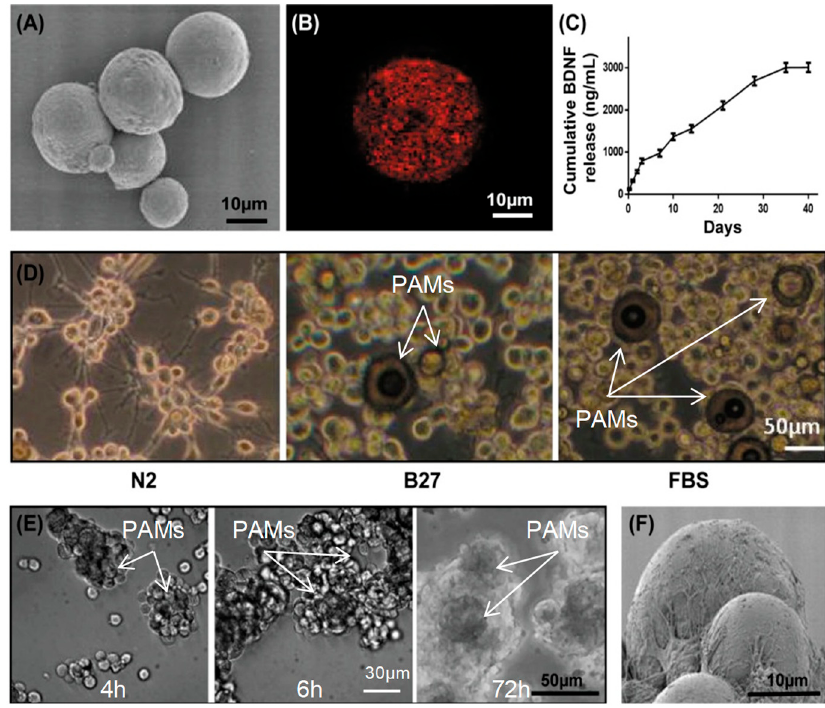
Figure 5. PAM characterization and adherence of GABA-like progenitors on PAMs. ( A ) PAMs observed using SEM and ( B ) laminin overlay onto PAMs observed by confocal microscopy after immunofluorescence. ( C ) Controlled release of BDNF from PAMs, measured using ELISA. ( D ) Different media were tested for the adher ence: 2% of B27, 15% of N2 and 3% of FBS. The last condition has been chosen for the rest of the experiments. ( E ) The cells were incubated with PAMs and pictures taken by brightfield microscopy at 4 h, 6 h and 72 h. ( F ) Observation of microspheres and cells-PAMs complexes by scanning electronic microscopy showing the cells adhering onto the PAMs. White arrows point at PAMs associated with cells.